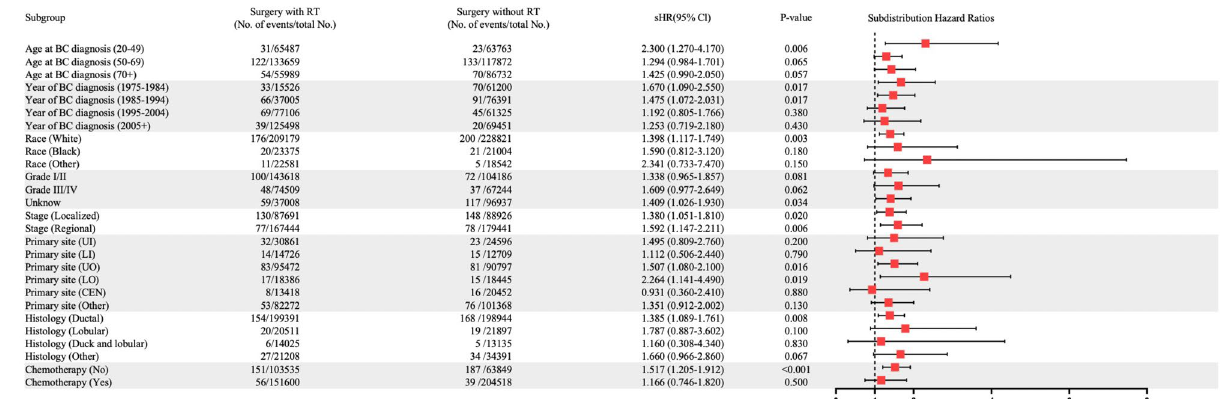
Figure 2. Subgroup analyses of competing risk regression for the risk of developing secondary esophageal cancer. BC breast cancer; RT radiation therapy; UO upper outer quadrant of breast; UI upper inner quadrant of breast; LI lower inner quadrant of breast; LO lower outer quadrant of breast; CEN central portion quadrant of breast. The other sites of BC include axillary tail of breast, overlapping lesion of breast. sHR subdistribution hazard